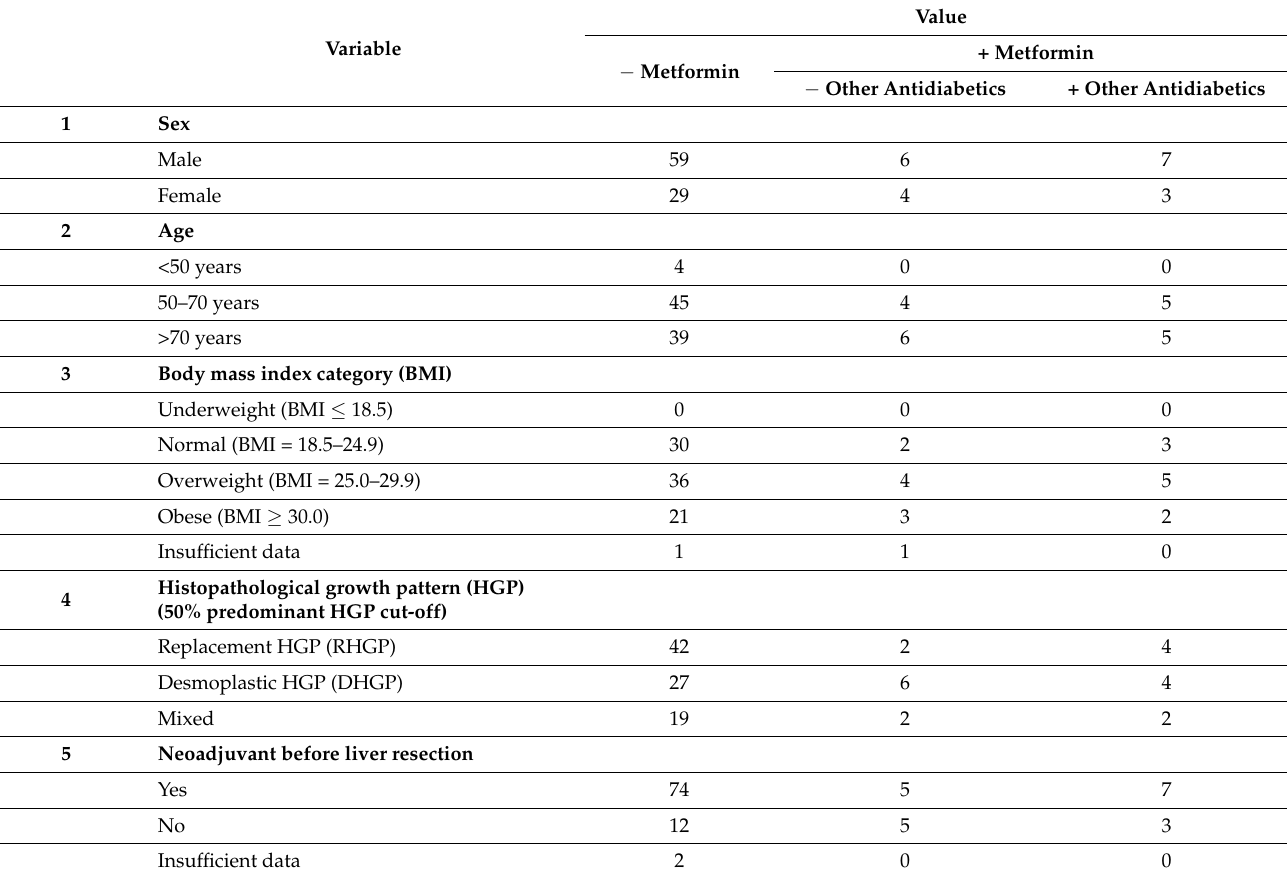
Table 1. Demographic baseline of CRCLM